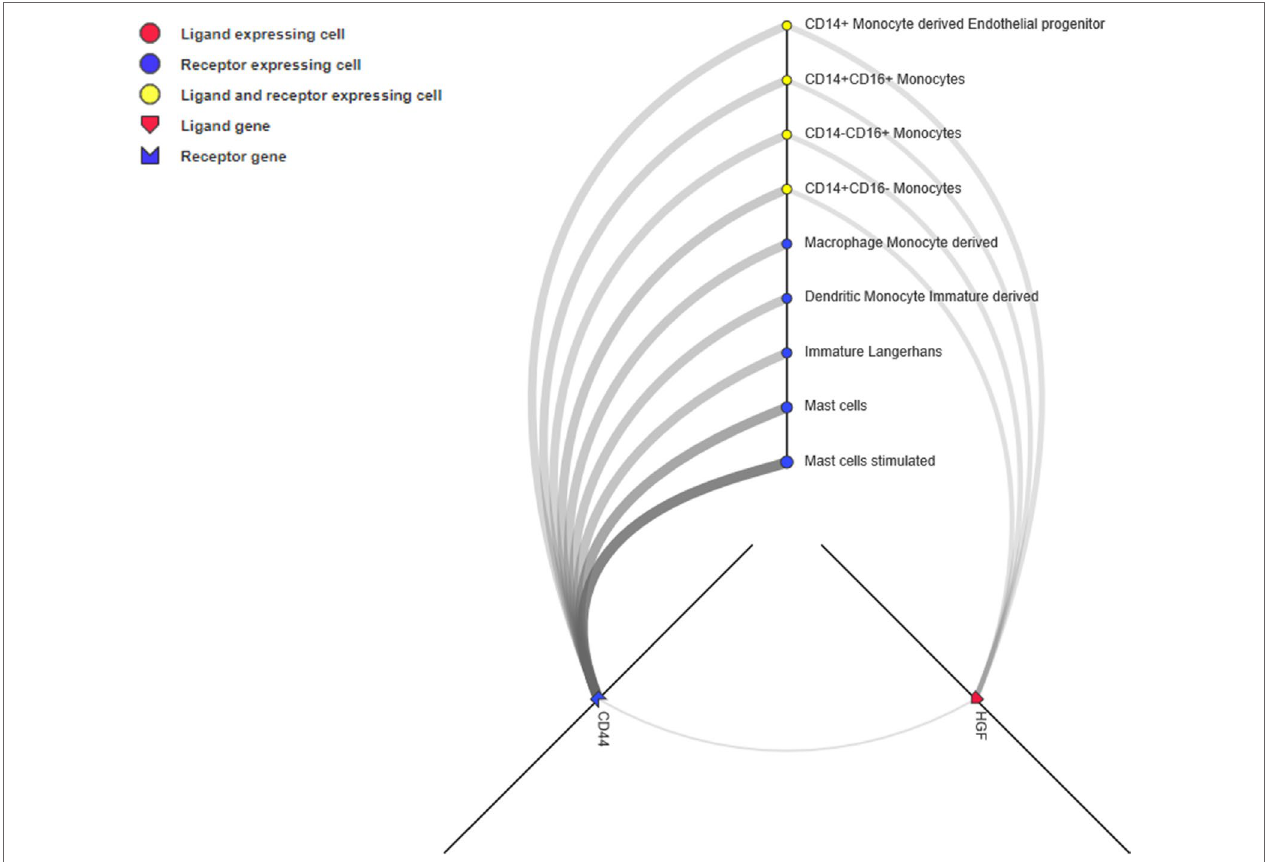
FIGURE 6 | CD44-HGF signaling network interface. In this network, both CD44 and hepatocyte growth factor (HGF) were expressed in monocytes (≥10 TPM). The interface is available at